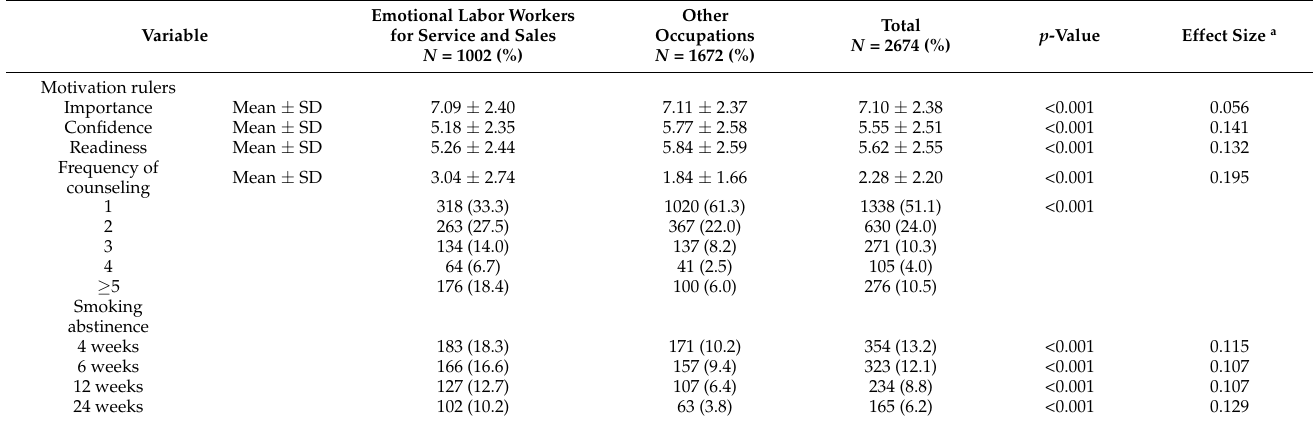
Table 2. Success factors in quitting smoking according to labor status.